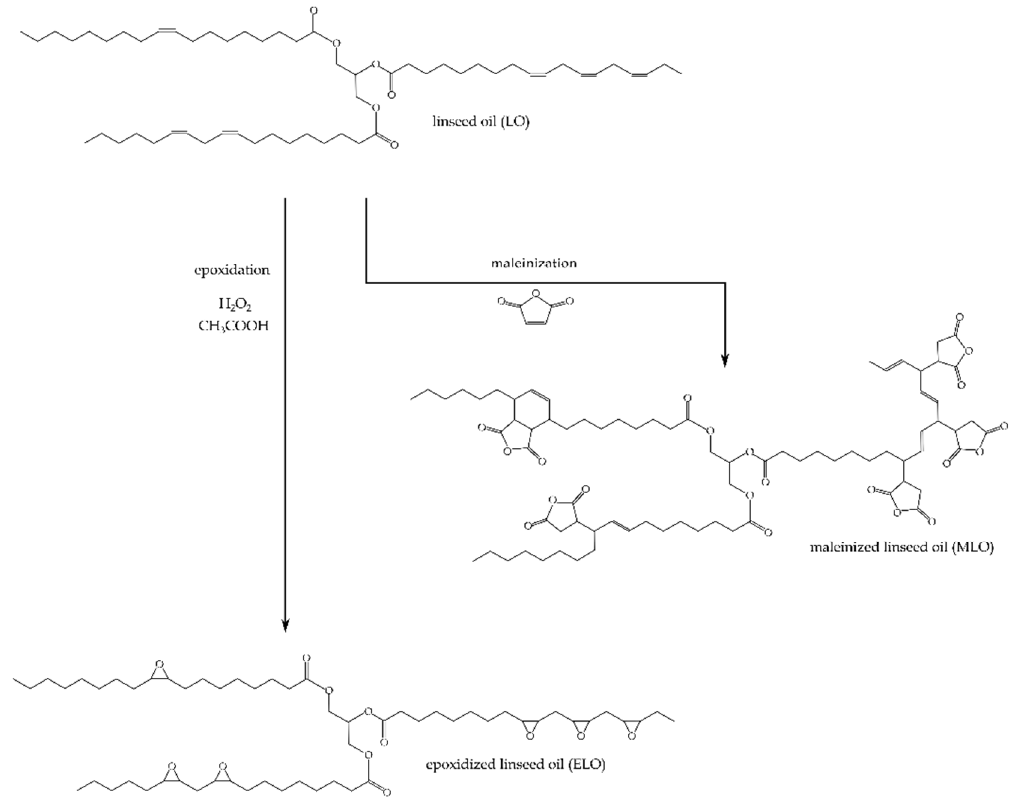
Figure 1. Chemical pathways used to obtain the base epoxy (epoxidized linseed oil, ELO) and the bio-based cross-linker (maleinized linseed oil, MLO).